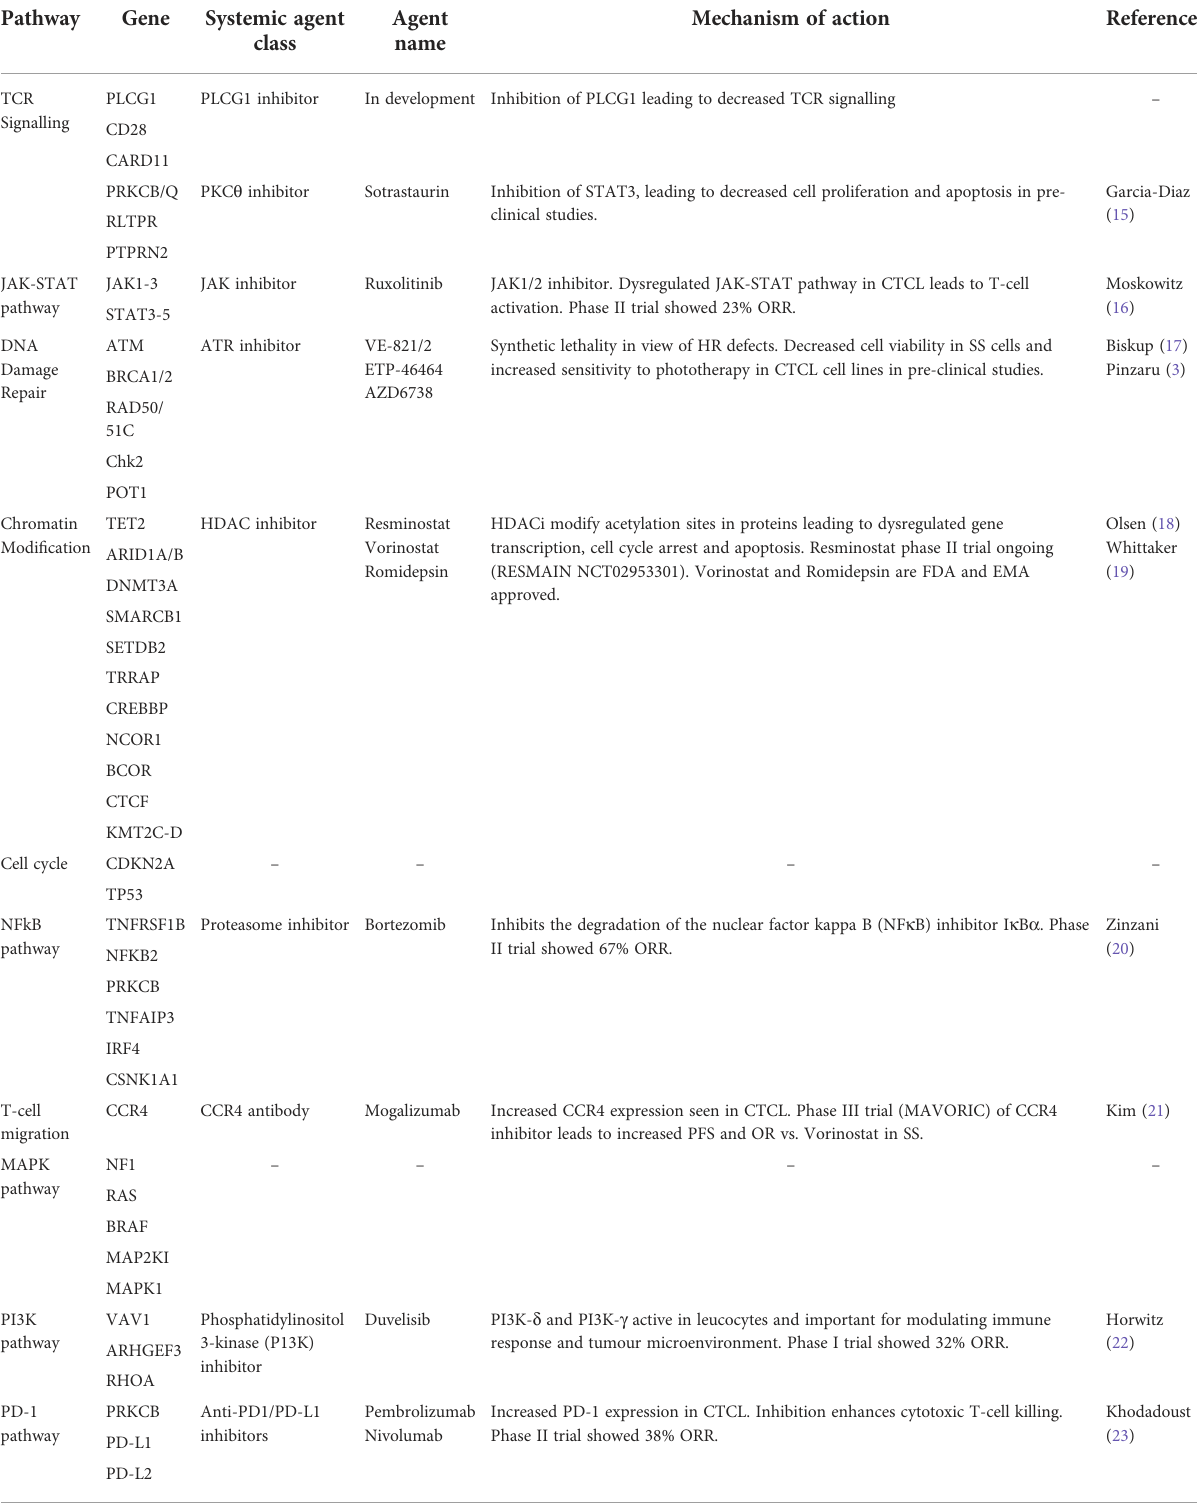
TABLE 1 Major aberrant pathways and associated emerging systemic therapies for advanced MF/SS.